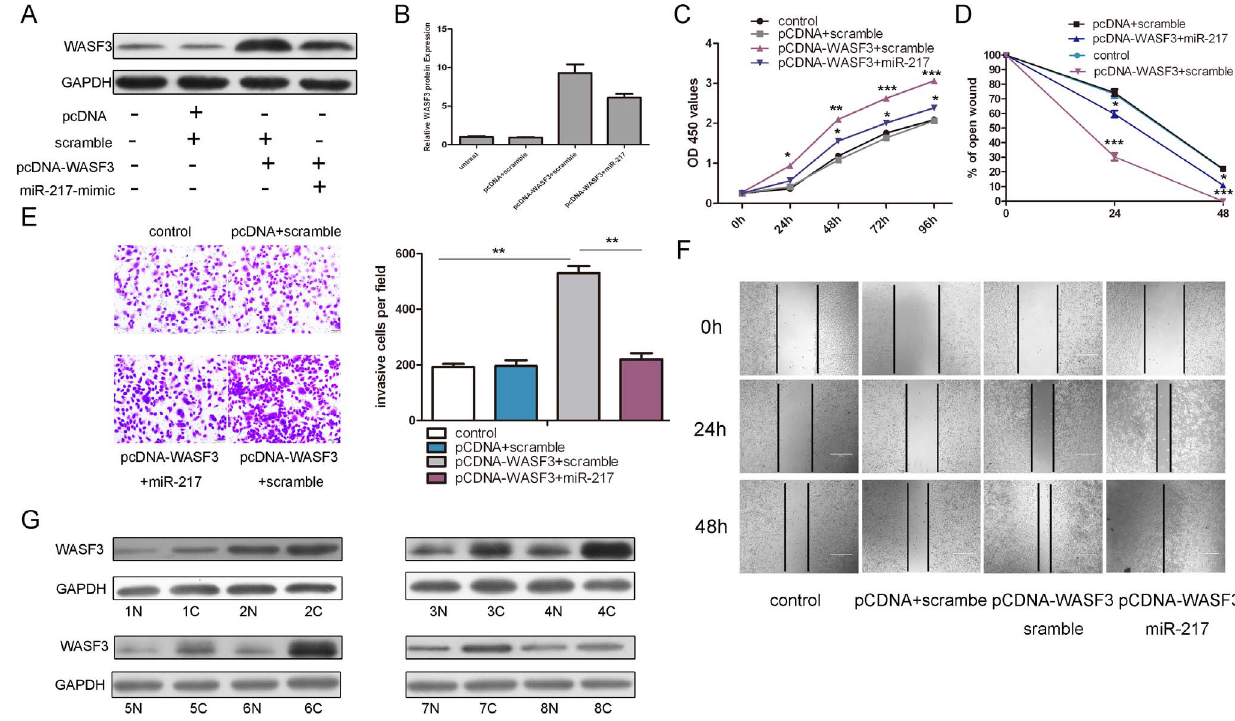
Figure 4. Restore WASF3 expression impairs miR-217-induced inhibition of proliferation and invasion in osteosarcoma cells. (A) Western blot analysis of WASF3 in MG-63 cells co-transfectedwith either miR-217 mimic or scramble and 2.0 m g pCDNA-WASF3 orpCDNA empty vector. (B) The relative WASF3 protein was showed with different combinations. The signal in each lane was quantified using ImageJ software and the ratio of WASF3 to GAPDH was determined. (C) Cell growth curves in MG-63 cells transfected with different combinations using CCK-8 analysis. (D) The relative ratio of wound closure per field with different combinations is shown. (E) Transwell analysis of MG-63 cells treated with different combinations. The invasive cells per field is shown right. (F) Wound healing assays of MG-63 cells after treatment with different combinations. (G) Western blot analysis of WASF3 expression in 8 miR-217 down-regulated osteosarcoma tissues and their pair-matched nontumor tissues. GAPDH was also detected as a loading control. All data uses t test and is shown as mean 6 SEM. *p , 0.05,** p , 0.01,***p ,